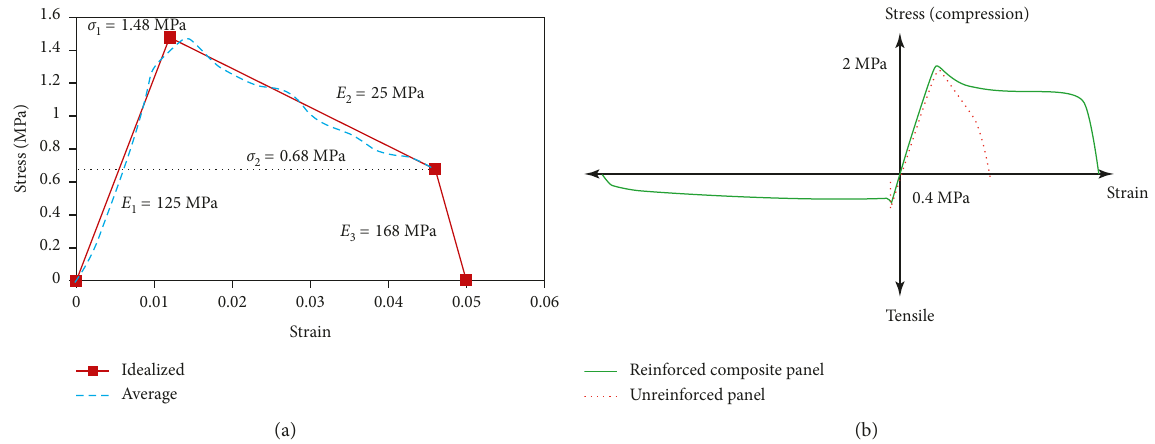
Figure 2: Stress-strain curve of gypsum. (a) Idealized experimental curve in the compressive regime. (b) Proposed stress-strain model in the compressive regime [19].